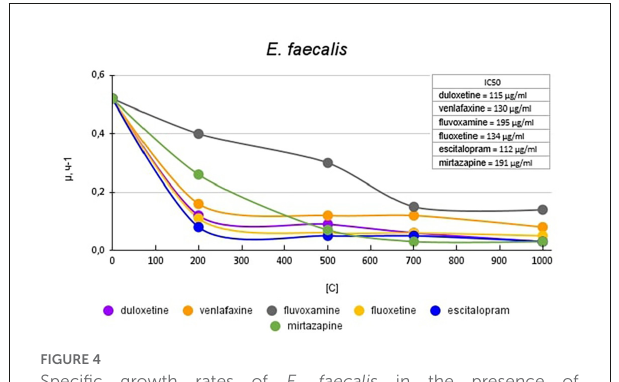
FIGURE5 Specificgrowthratesof S.aureus